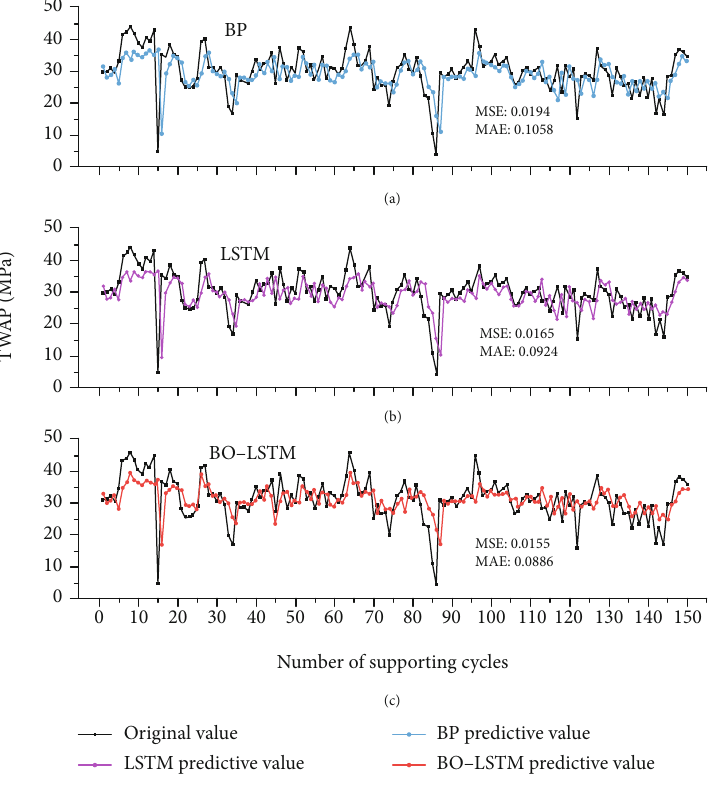
Figure 11: Comparison among the TWAP prediction performances of three models for 40#